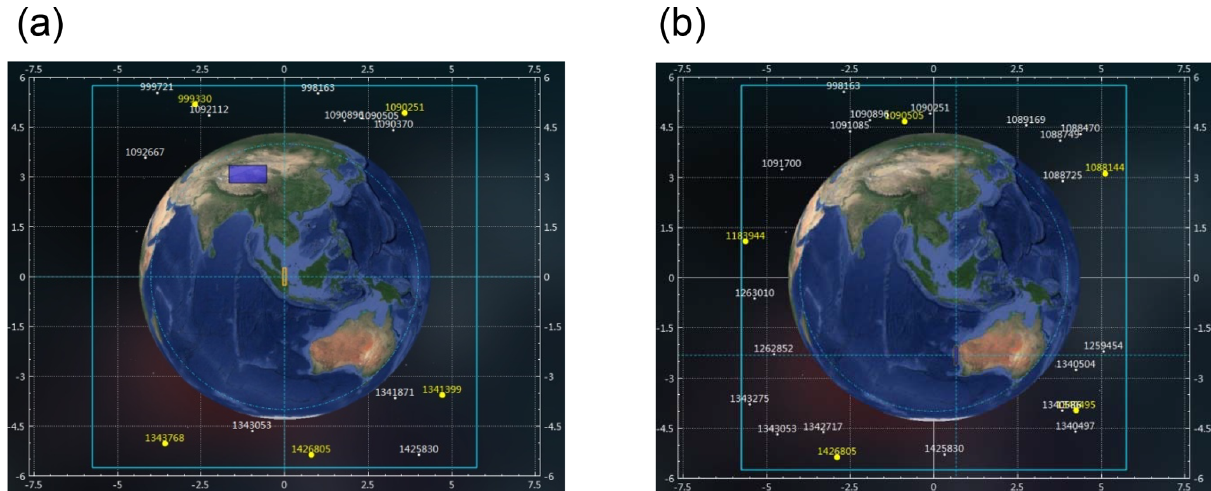
Figure 8. GIIRS typical tasks: (a) regional observation of China and (b) landmark observation of the western coastline of Australia.